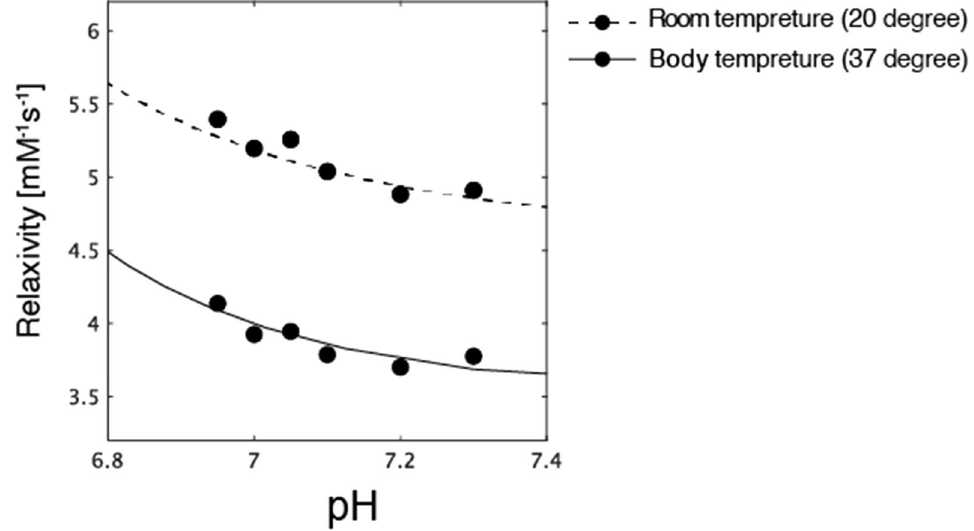
Figure 3. Determination of the pHe-relaxivity calibration curve for Gd-BTDO3A. These measurements were performed at room temperature (20 °C) and body temperature (37 °C) on a clinical 3.0 T MRI scanner.